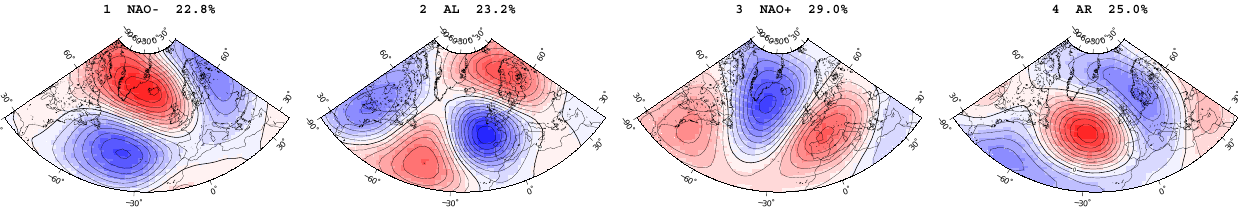
Fig. 2. ERA40 Z500 clusters (NAO-, Atlantic Low, NAO+, Atlantic Ridge) and their corresponding frequency of occurrence. Contour interval 0.1 (normalised variable).